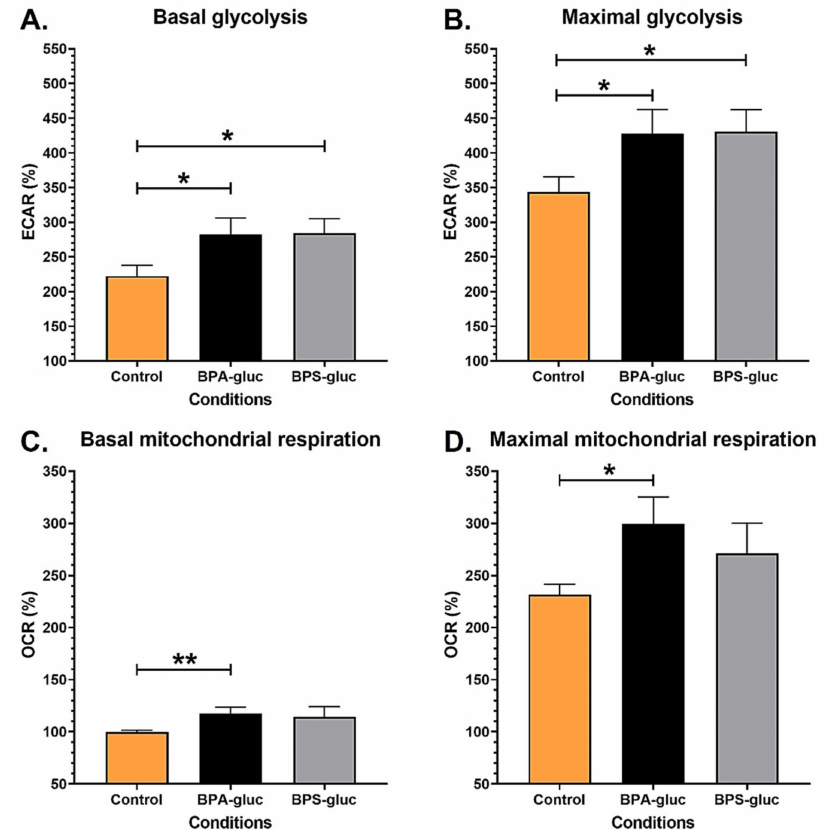
Figure 2. Chronic exposure to physiological concentrations of BPA and BPS glucuronidated metabo- lites increases the glycolytic and mitochondrial capacities of RT4 non-invasive bladder cancer cells. ( A , B ) ECAR and ( C , D ) OCR were determined using the XFe96 Extracellular Flux Analyzer of RT4 non-invasive bladder cancer cells with or without chronic exposure to physiological concentrations of BPA-gluc or BPS-gluc to establish ( A ) basal glycolytic capacity, ( B ) maximal glycolytic capacity, ( C ) basal mitochondrial respiration and ( D ) maximal mitochondrial capacity. Data are presented as the mean ± SEM and displayed as percentages of controls (i.e., untreated condition) (n ≥ 3, N = 3). The baseline (100%) was established before injections (see Figure S2). * p < 0.05, ** p < 0.01 by Mann–Whitney